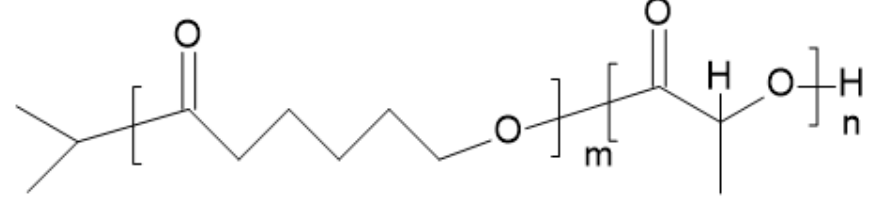
Figure 20. Chemical structure of diPCLPLA block copolymer [75].